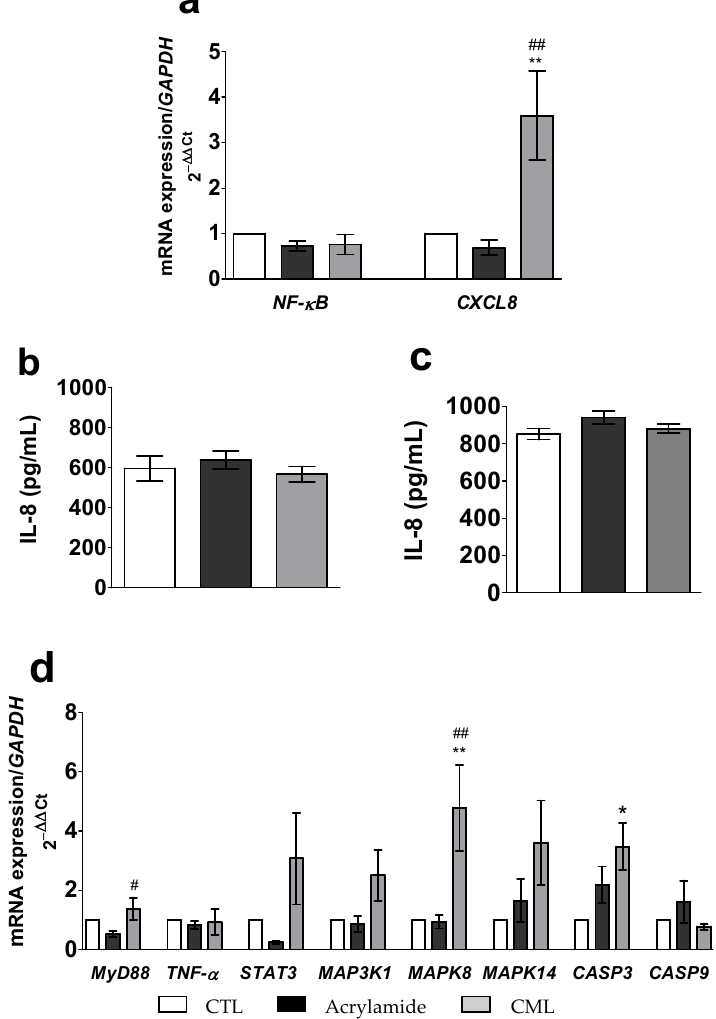
Figure 6. Effect of a 6 h incubation with CML (300 μM) or acrylamide (5 mM) on relative mRNA expressions of genes coding for NF-κB and CXCL8 ( a ) measured by qPCR, and on IL-8 secretion measured by ELISA, in the apical ( b ) and the basal ( c ) media, and on the relative mRNA expression of genes coding for the pro-inflammatory and pro-apoptotic signaling pathways measured by qPCR ( d ) from the Caco-2/TC7 and HT29-MTX co-culture. Data were expressed as mean ± SEM ( n = 12). The level of gene expression was expressed as the fold induction over the CTL group set at 1. *, **, statistically significant difference ( p < 0.05; p < 0.01 vs. CTL); #, ## statistically significant difference ( p < 0.05; p < 0.01 vs. acrylamide). CML, N ε -Carboxymethyllysine; CTL, control CASP3 , Caspase 3; CASP9 , Caspase 9; CXCL8 , Interleukin 8; MAP3K1 , mitogen-activated protein kinase 1; MAPK8 , mitogen-activated protein kinase 8; MAPK14 , mitogen-activated protein kinase 14, also called p38- α ; MyD88 , myeloid differentiation primary response gene 88; NF- κ B , nuclear factor-kappa B; STAT3 , signal transducer and activator of transcription 3; TNF- α , tumor necrosis factors α